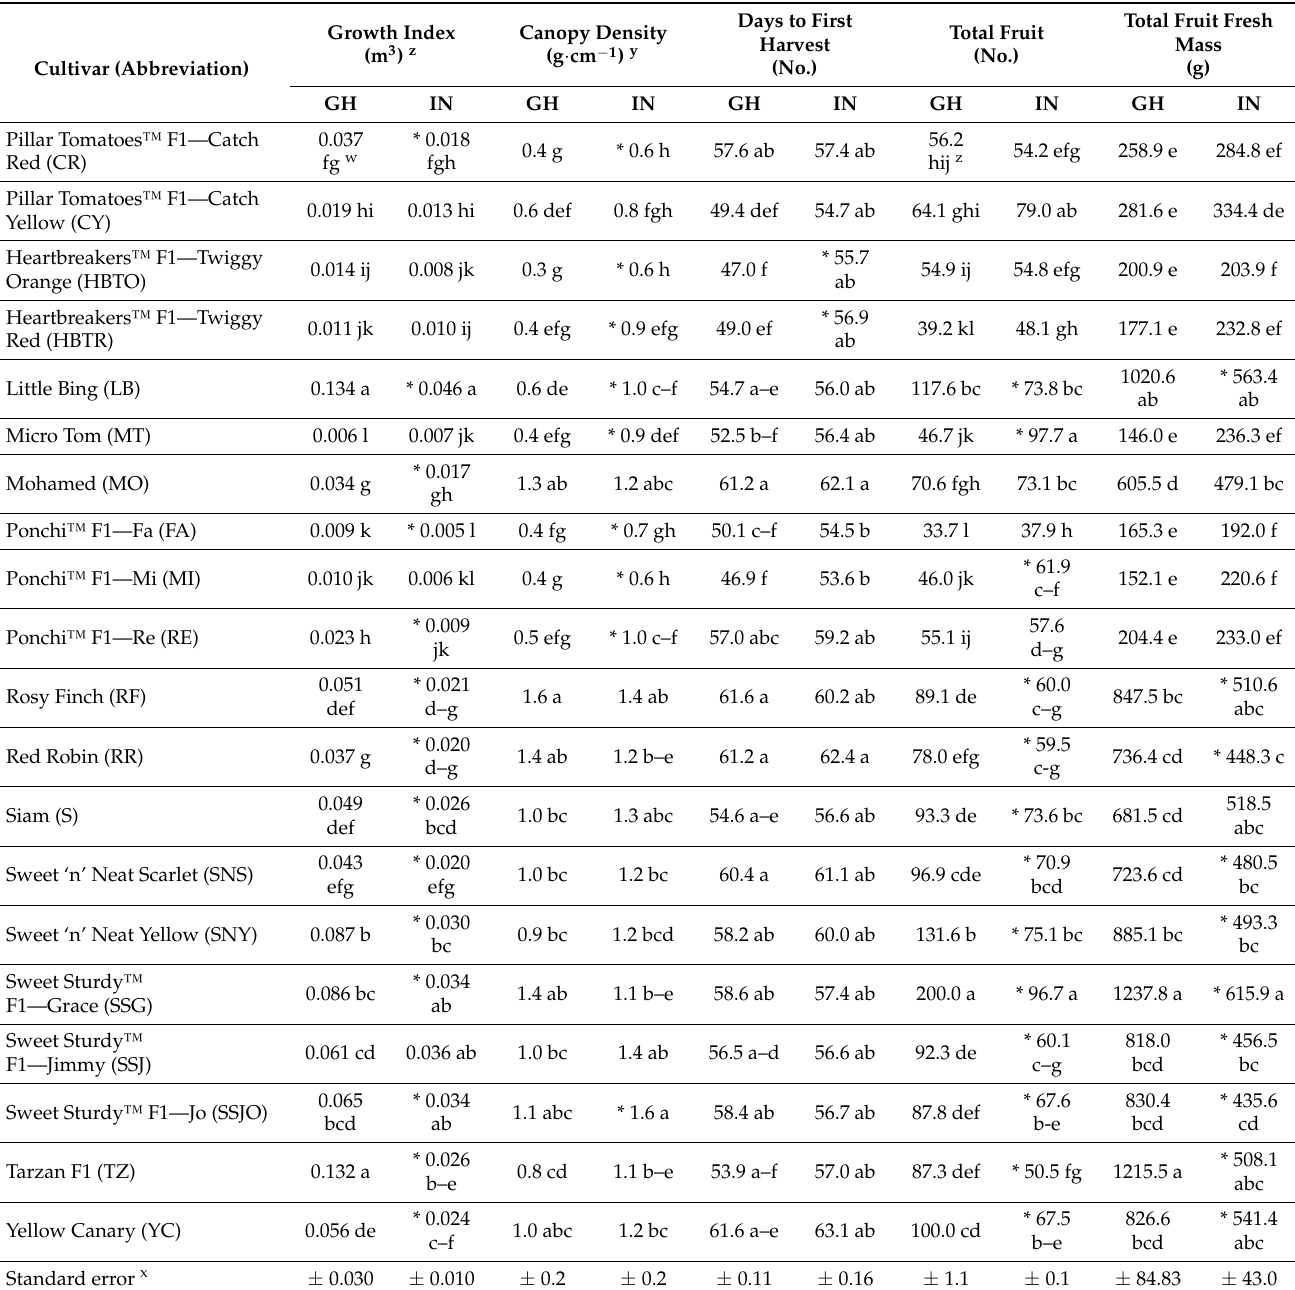
Table 2. Growth parameters for compact tomato cultivars grown in a greenhouse (GH) or an indoor (IN)